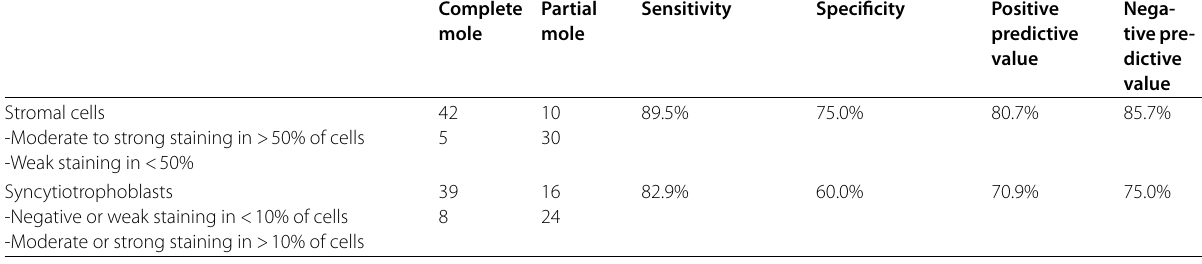
Complete Partial Sensitivity Specificity Positive mole mole